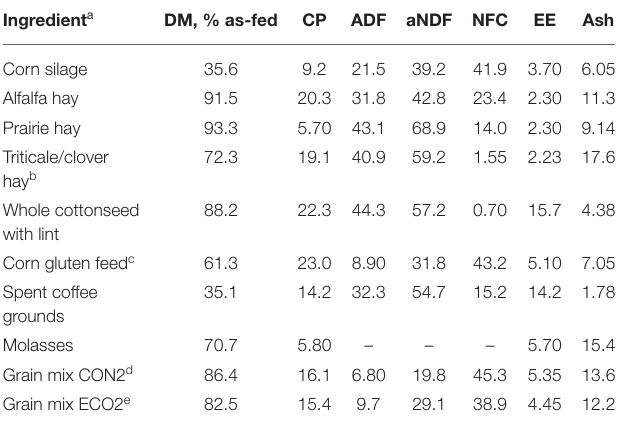
TABLE 4 | Chemical composition of feeds used in Experiment 2 (% of DM unless otherwise labeled). Ingredient